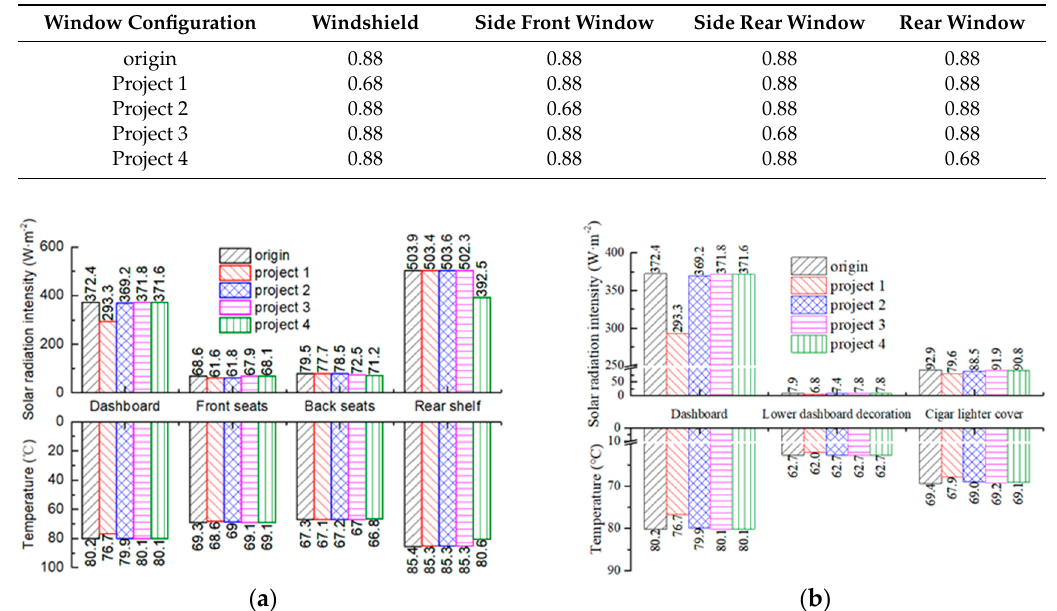
Table 7. Setting glazing transmissivity in different windows.